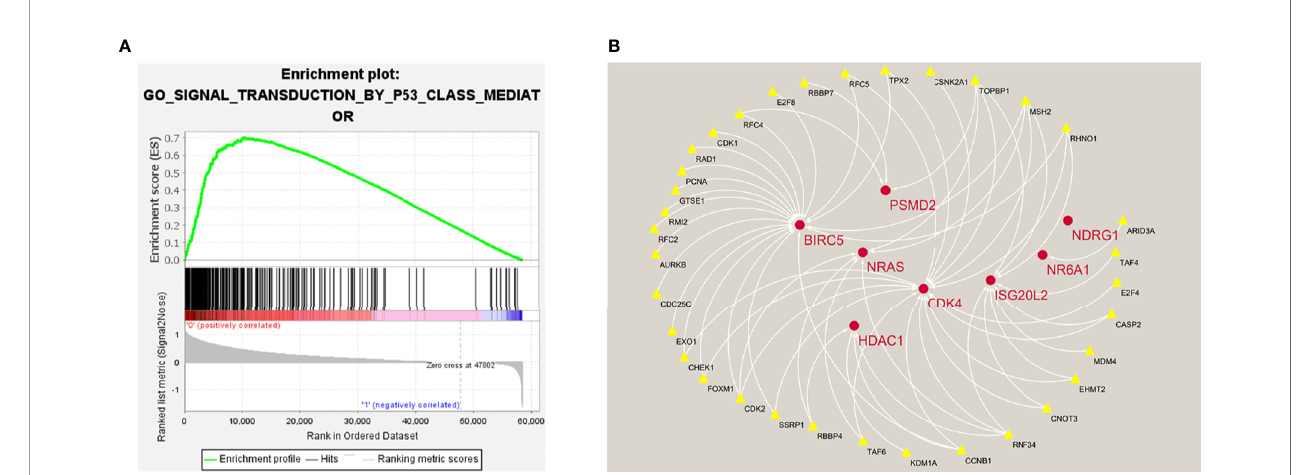
FIGURE 11 | (A) Enrichment plot of 261 genes enriched on the signal transduction pathway of p53 class mediator. (B) Regulatory networks between prognosis- related immune genes and genes enriched in the pathway. There are three genes ( BIRC5 , HDAC1 , NR6A1 ) in the model that participate in the hub of the